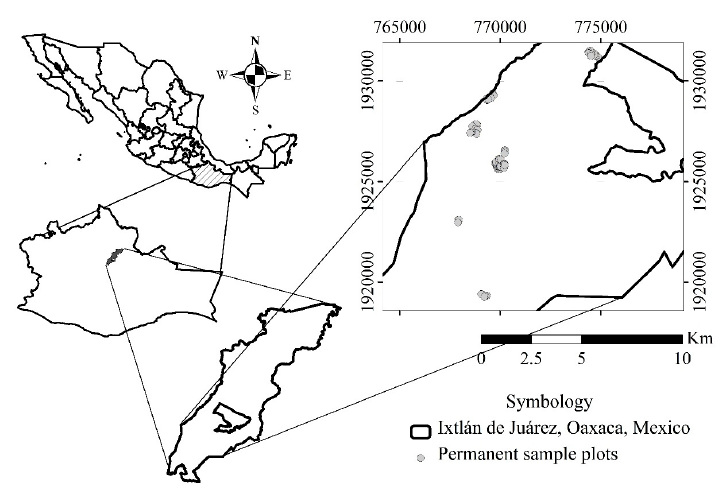
Figure 1. Location of the study area.